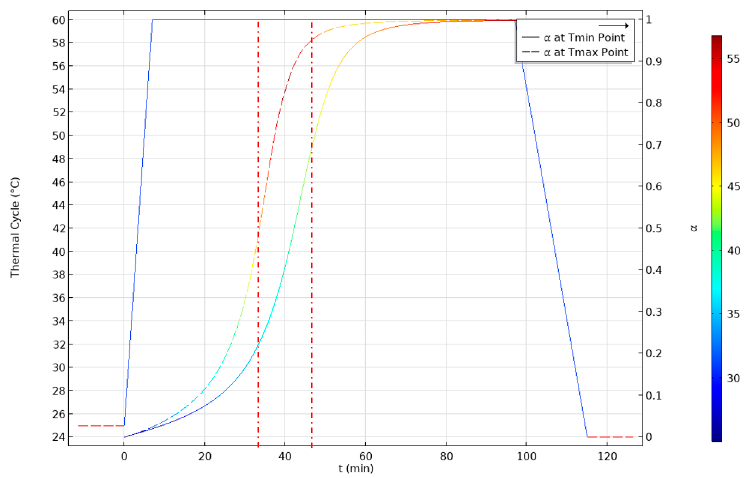
Figure 14. DoP evolution during the thermal cycle.